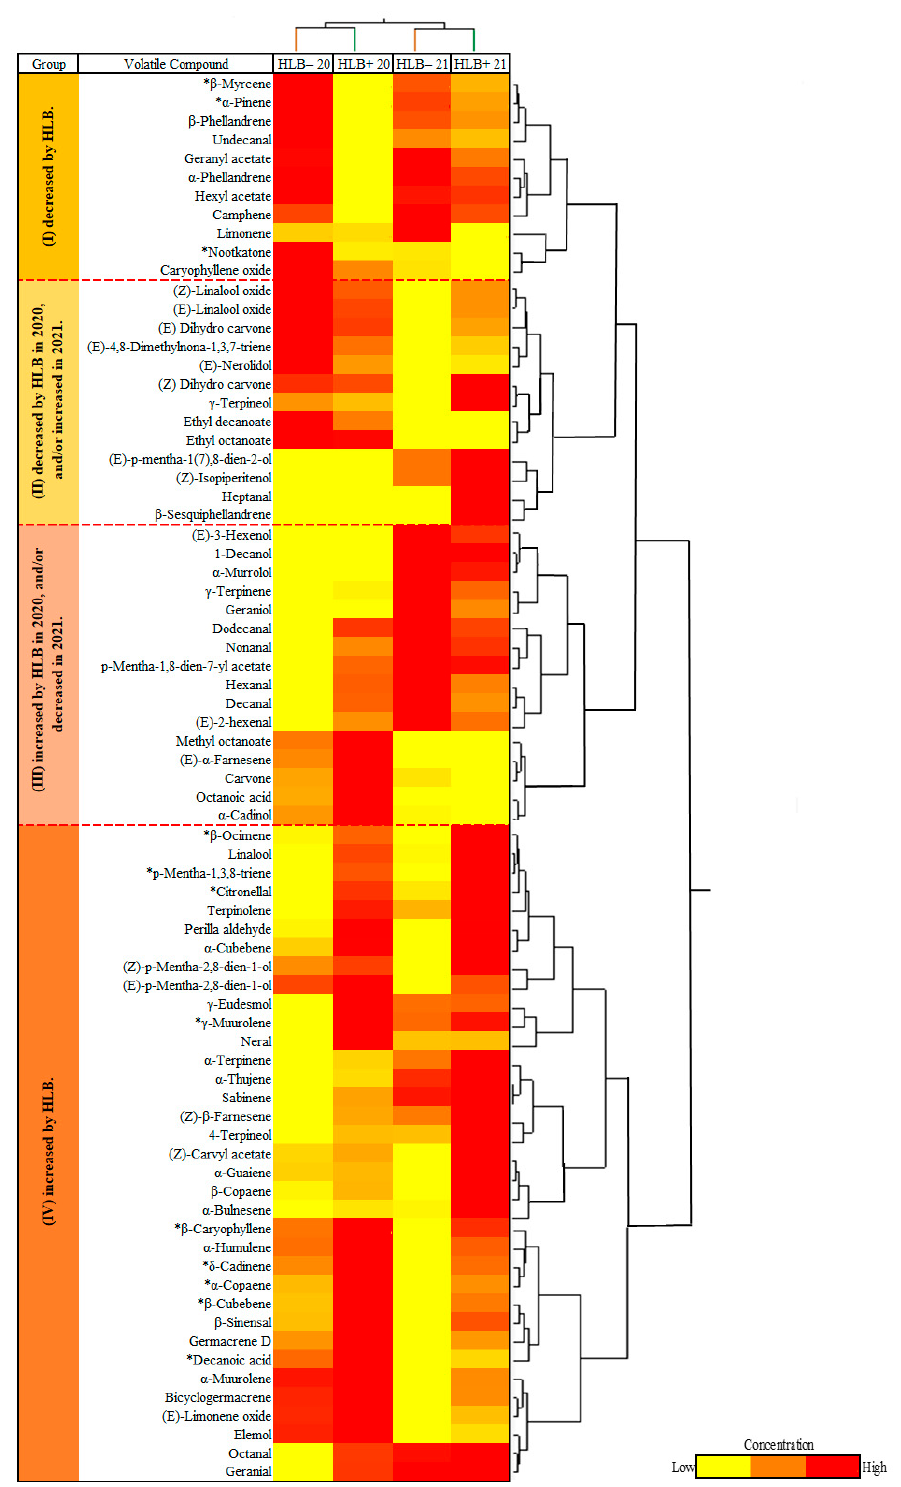
Figure 3. Combined cluster analysis and heat map of grapefruit peel oil samples from healthy (HLB − ) and HLB-affected fruits (HLB+) from 2020 (HLB − 20 and HLB+ 20) and 2021 (HLB − 21 and HLB+ 21) harvests (columns) and identified VOCs (rows). Chemical groups increased and/or decreased by Huanglongbing (HLB) determined by the average concentration of volatiles in peel oil extracted from ‘Ray Ruby’ grapefruit in two harvest seasons, 2020 and 2021. * Significant differences at p ≤ 0.05 according to Tukey’s HSD test in both